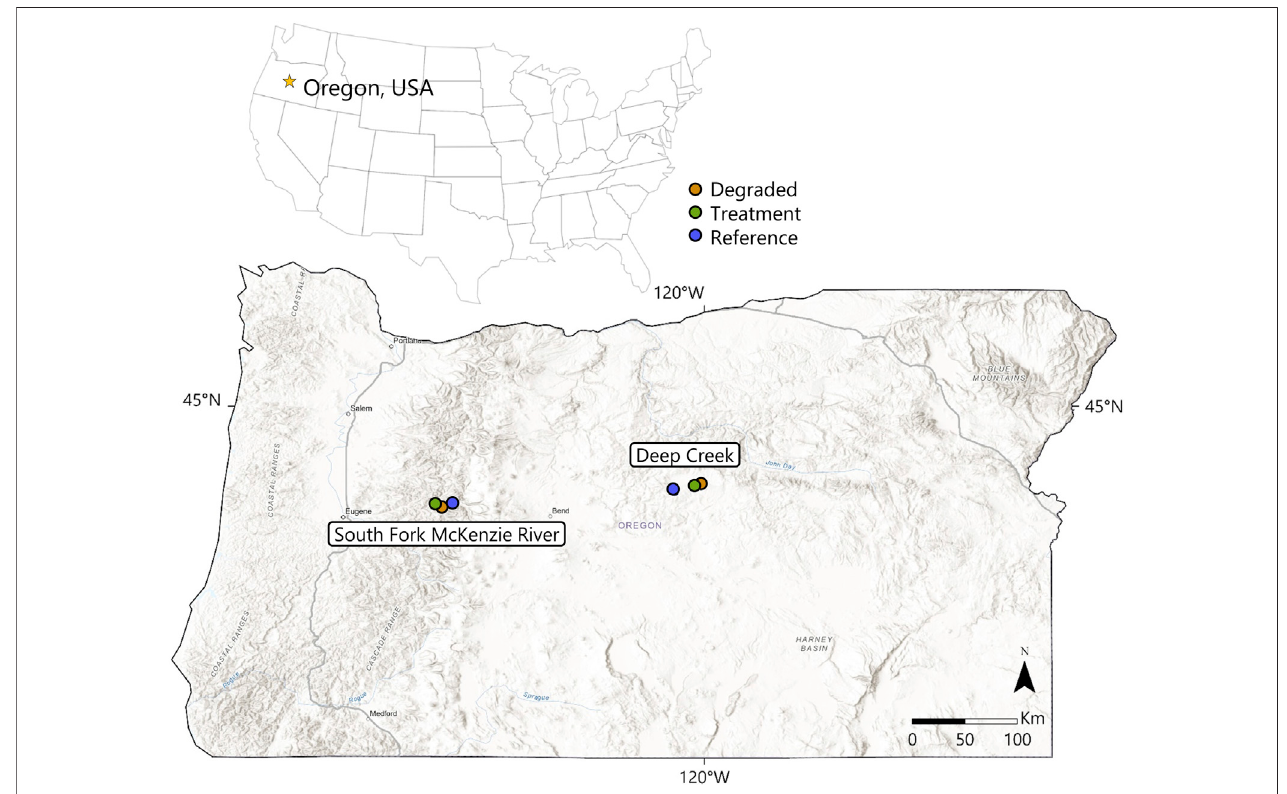
FIGURE 4 | Location map of the sites in Oregon, United States used as case studies in this paper.